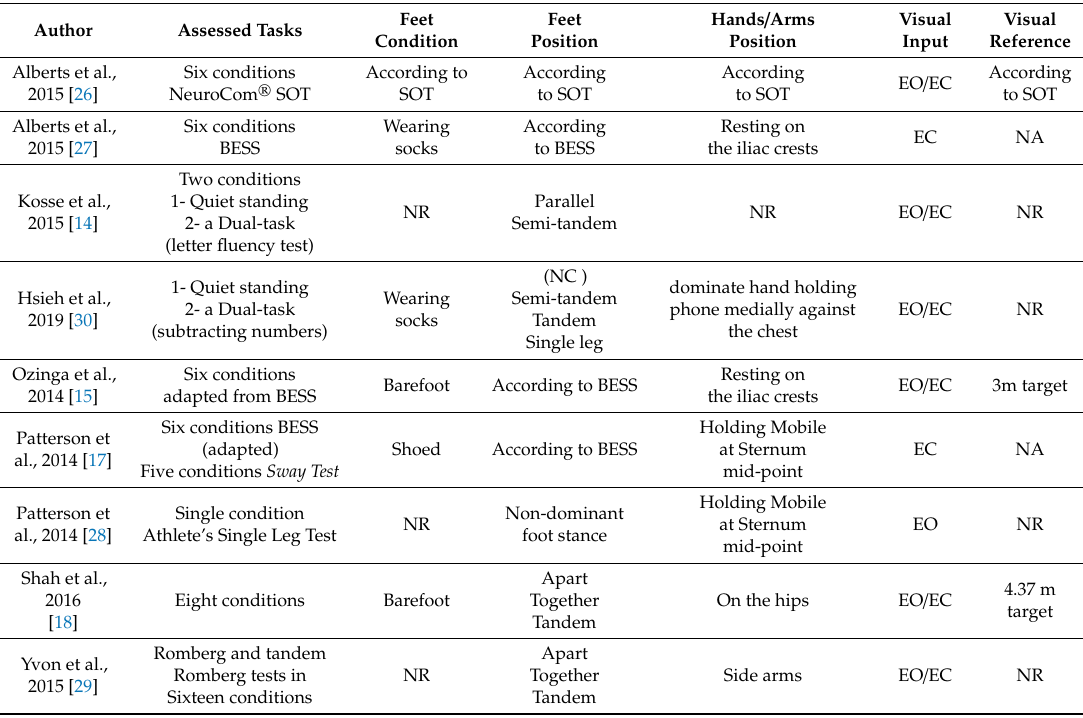
Table 2. Tasks and balance assessment